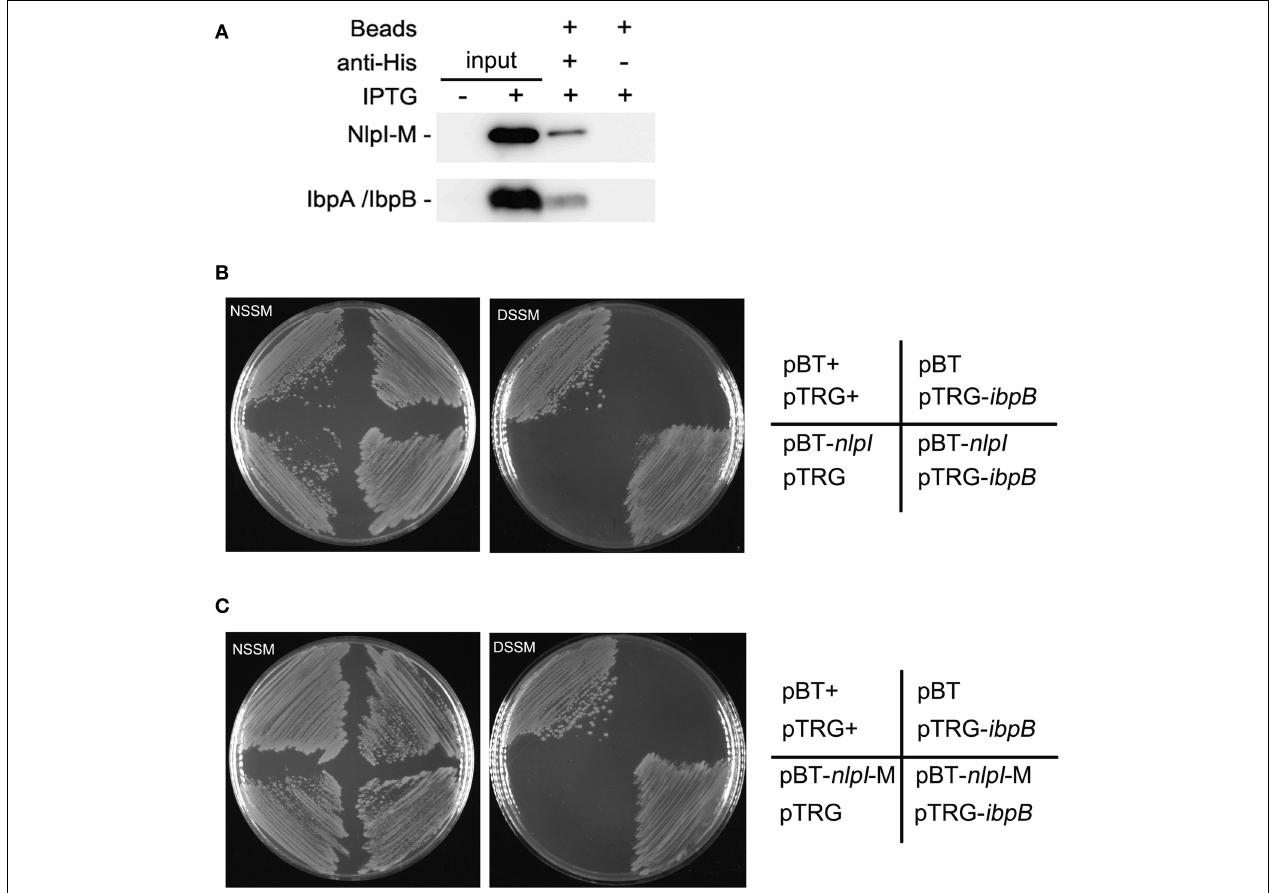
FIGURE 6 | NlpI physically interacts with IbpB. (A) Co-IP assays for the binding of NlpI-M with protein A beads by using anti-HisTag antibody. Immune complexes in MG1655/pQE80- nlpI -M induced with IPTG were collected, and the beads were washed with IP Lysis/Wash buffer. The samples were analyzed by using anti-IbpA antibody and anti-HisTag antibody, respectively. Lane 1 and lane 2 represented input CP of the